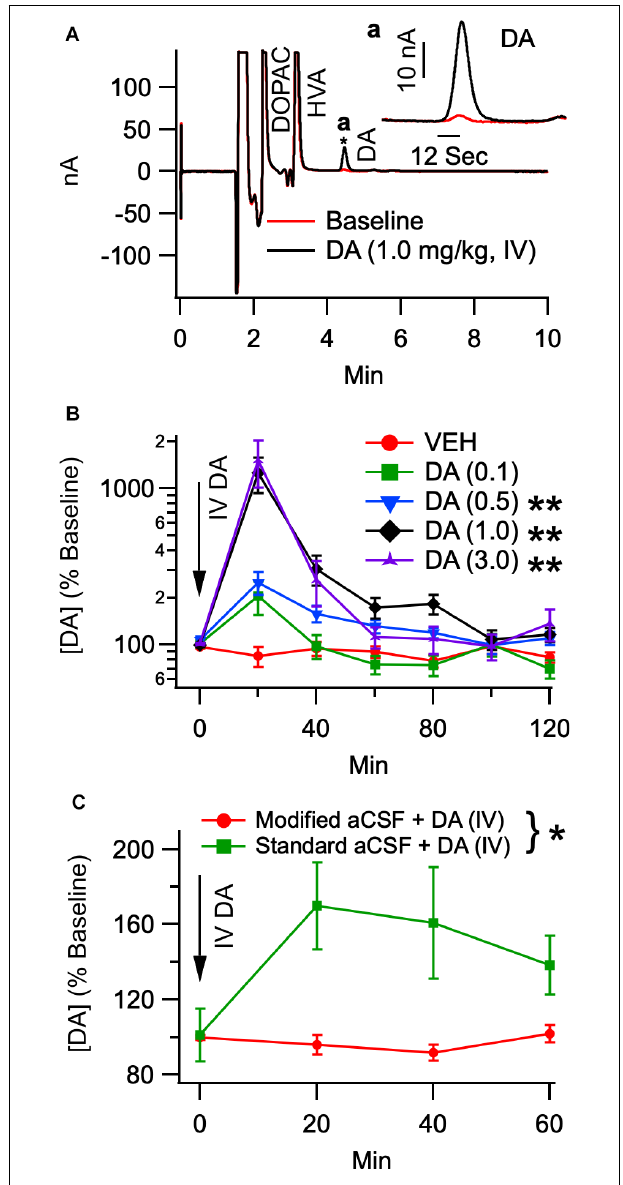
FIGURE 1 | Intravenous DA enhances dopamine release in the NAc in a dose-dependent manner. (A) Representative chromatogram of dialysate analyzed by HPLC before and after IV DA (1.0 mg/kg). The trace from a final baseline sample is superimposed with the trace from the first collection following an infusion of IV DA. The inset in the top right corner displays a magnified view of only the DA peaks from the two collections. An asterisk indicates where the inset is zoomed in. (B) Dopamine levels in the NAc were dose-dependently enhanced by IV DA doses of 0.1 mg/kg ( n = 8), 0.5 mg/kg ( n = 8), 1.0 mg/kg ( n = 18), and 3.0 mg/kg ( n = 10). This was most pronounced in the first 20 min after IV DA administration. (C) To determine whether IV DA enhanced DA levels in the NAc through an action potential dependent mechanism IV DA (1.0 mg/kg) was administered twice in the same rat. One administration occurred while the probe was being perfused with standard aCSF while another administration occurred while the probe was being perfused with modified aCSF, revealing that IV DA was unable to enhance DA levels in the NAc in the presence of lidocaine and the absence of calcium. Asterisk *, ** indicates p < 0.05 and p < 0.01,